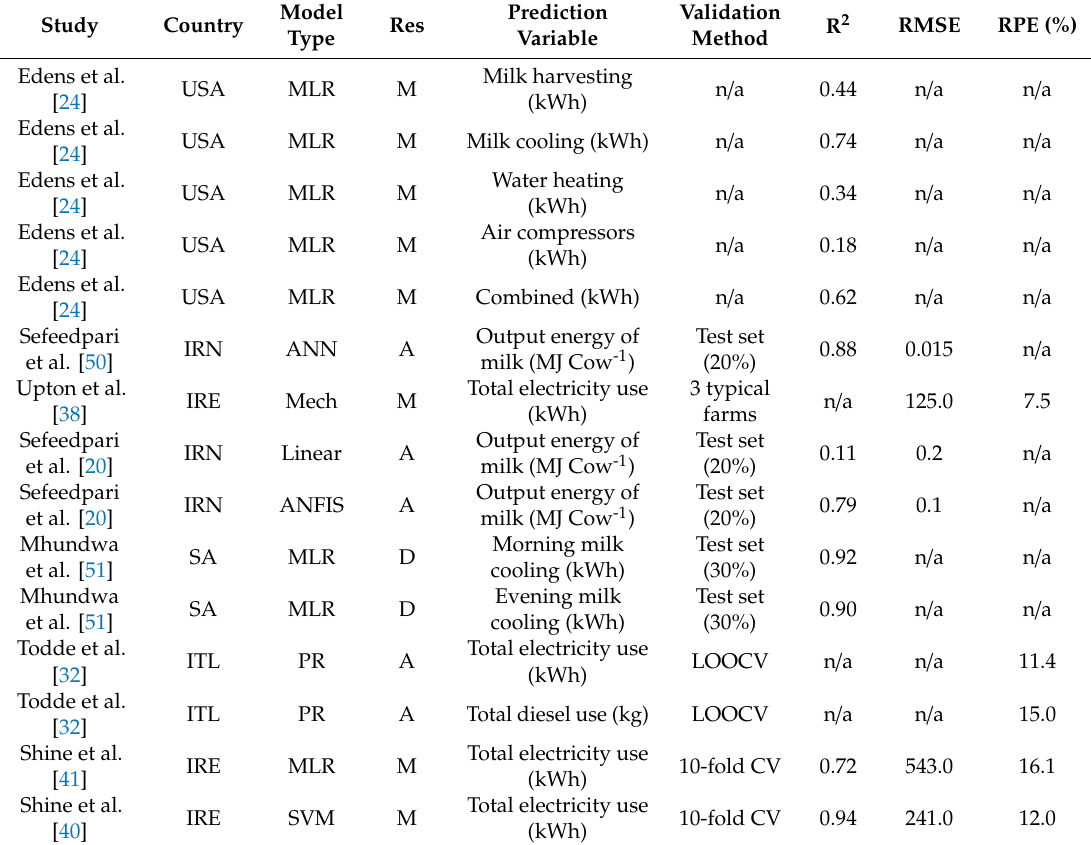
Table 6. Summary of models developed for predicting energy consumption on dairy